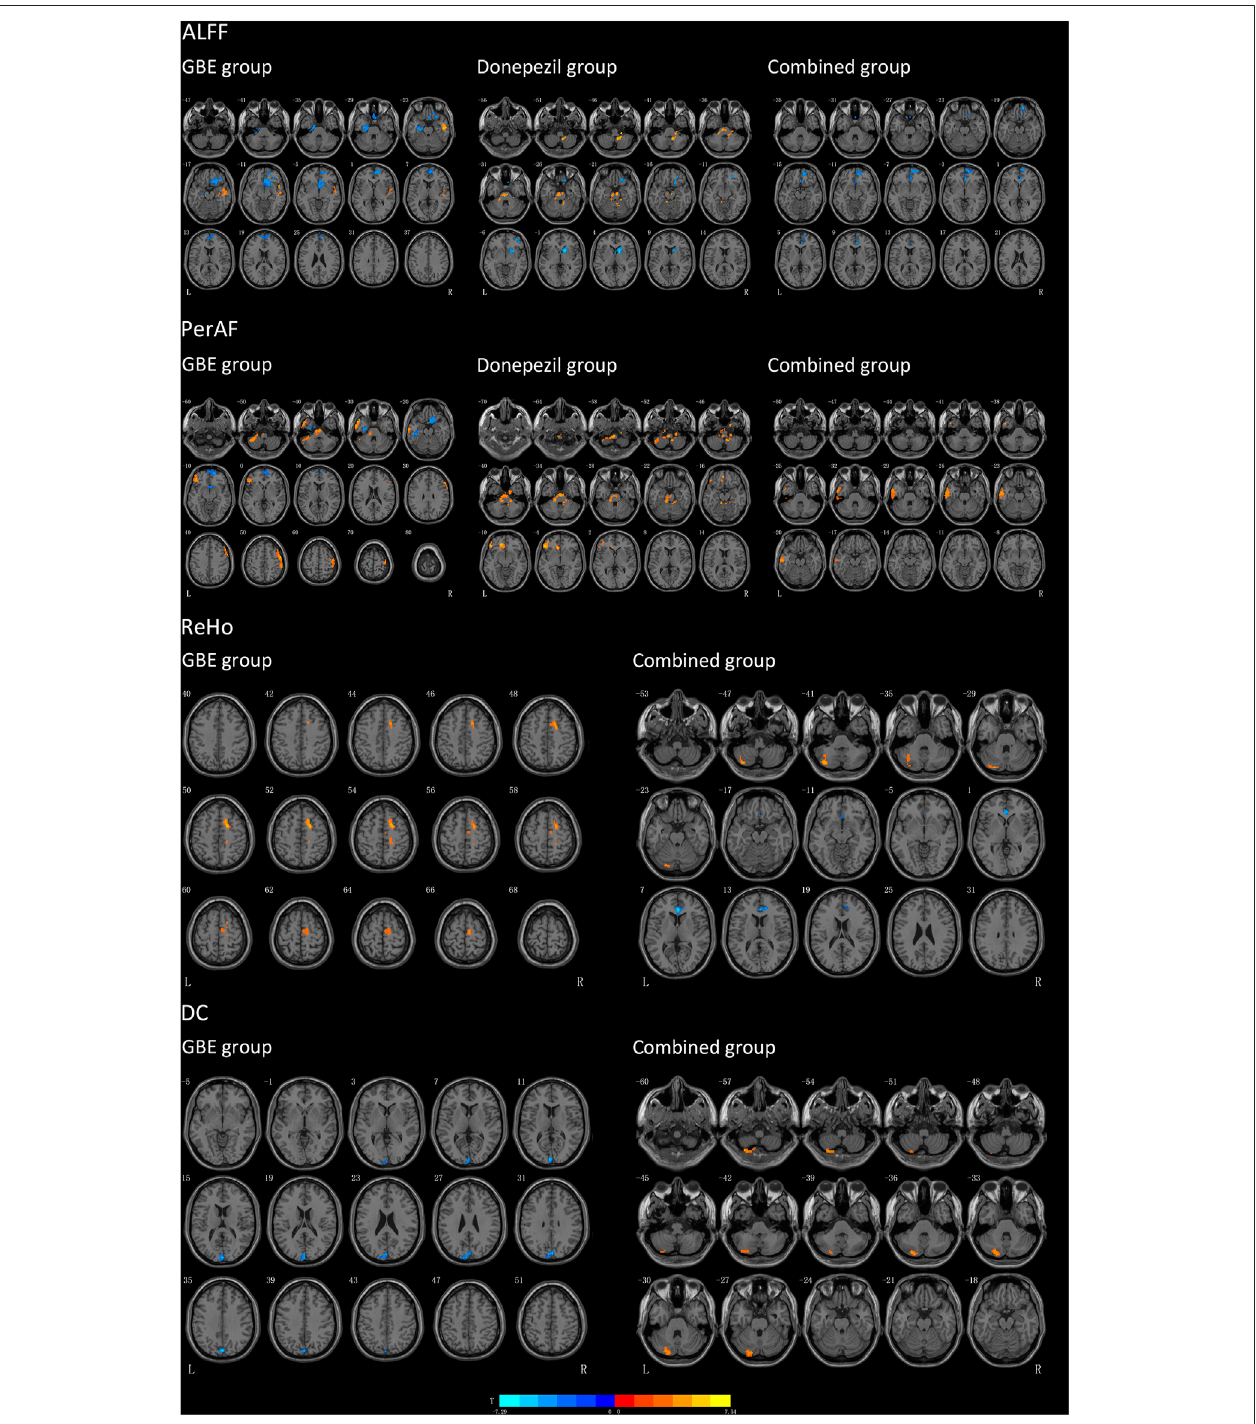
FIGURE 2 | Results of brain regions demonstrate signi fi cant differences in three groups pre-and post-intervention. The pseudo-color map revealed increases in ALFF, PerAF, ReHo and DC following the intervention. Results are displayed at p < 0.005 corrected by GRF. T value obtained from paired t -test of the group. GBE: Ginkgobilobaextract;ALFF:amplitudeoflow-frequency fl uctuation;PerAF:percent amplitudeof fl uctuation;DC:degreecentrality;ReHo: reginalhomogeneity;R:right; L: left.